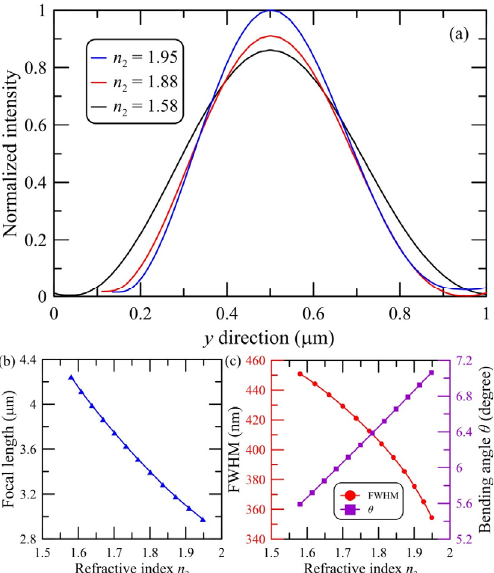
Figure 5. ( a ) Normalized intensity profiles of the photonic hooks along the y direction for triangular Janus micro-prisms at different refractive index n 2 . ( b ) Focal length, ( c ) FWHM and bending angle as a function of the refractive index n 2 of the triangular micro-prisms.